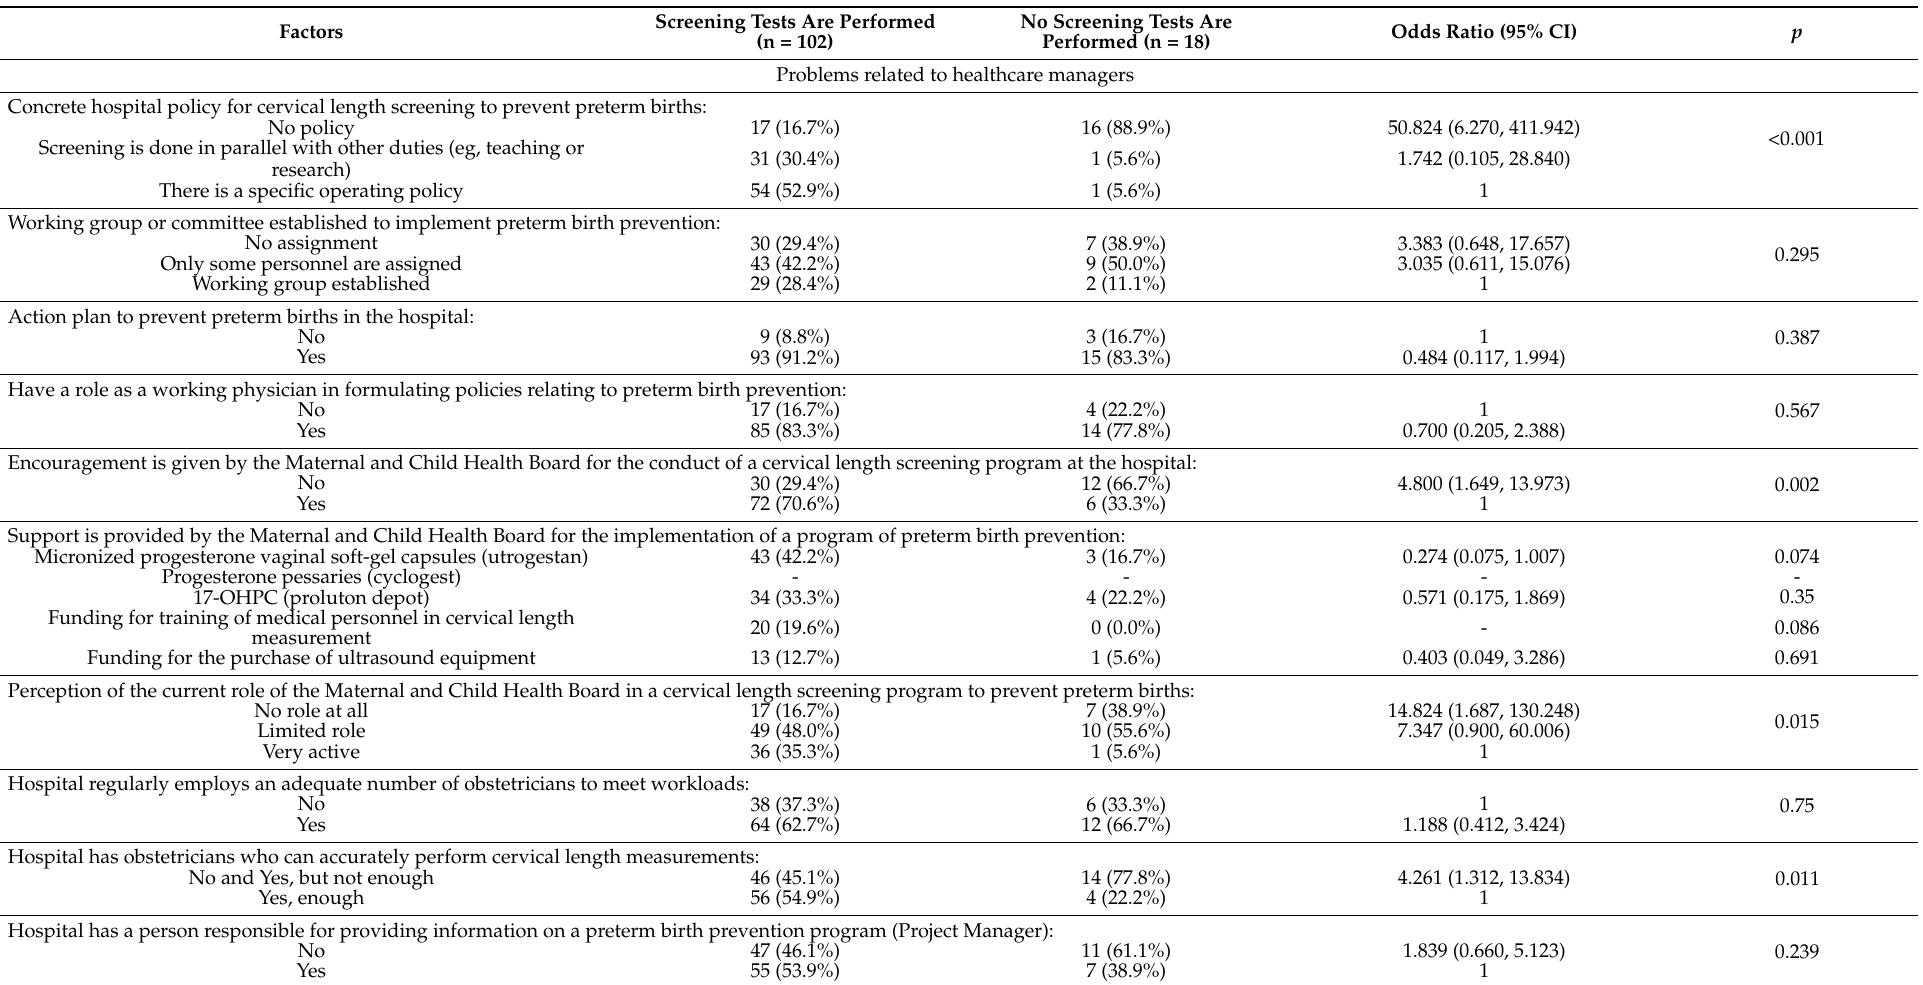
Table 2. Factors associated with implementing the Ministry of Public Health policy for universal cervical length screening in order to prevent preterm births.